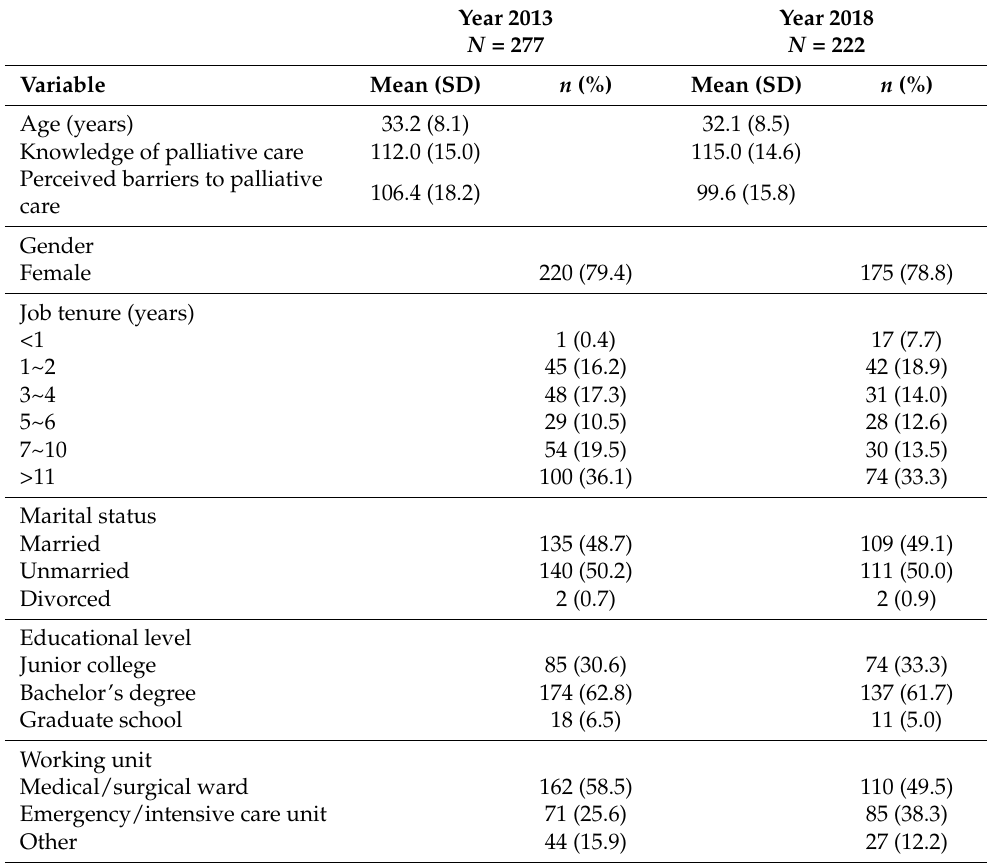
Table 1. Characteristics of participants in 2013 and